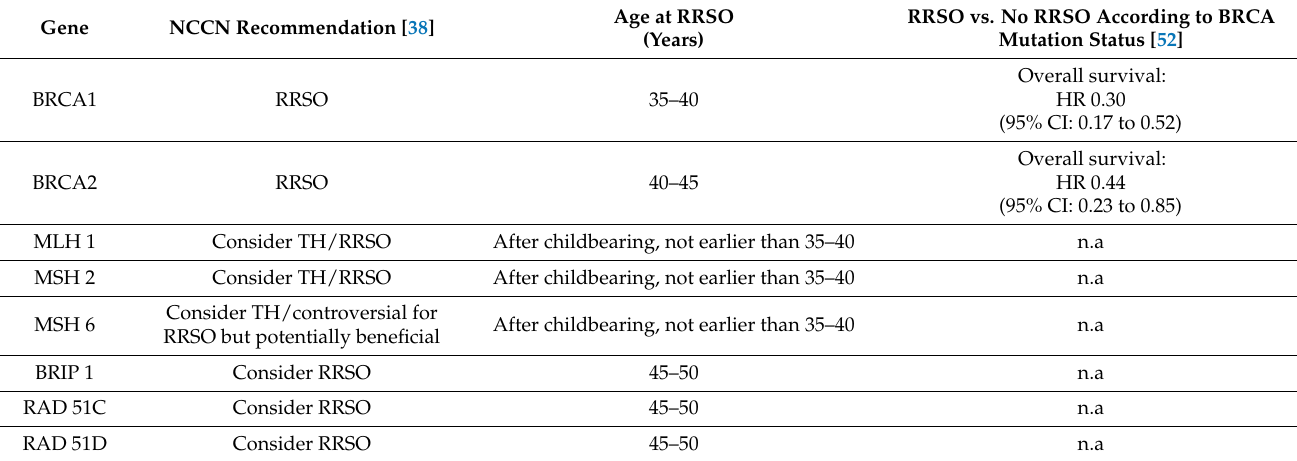
Table 2. Summary of OC risk for RRSO by